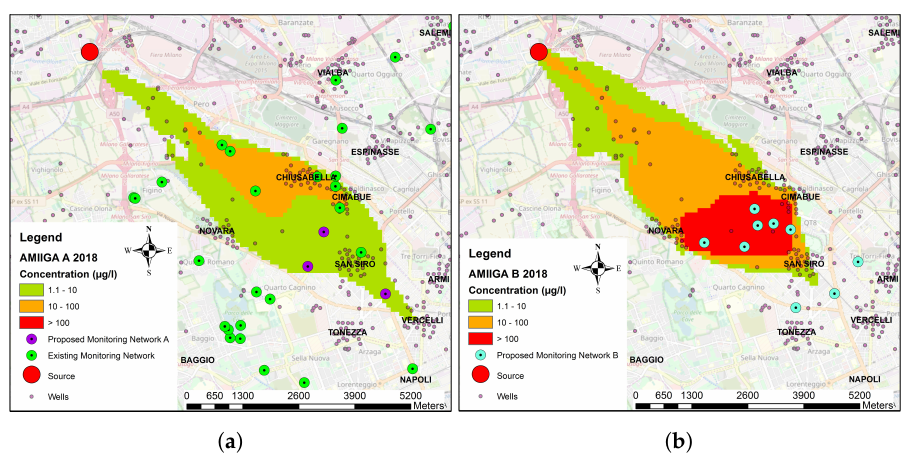
Figure 11. Proposed monitoring networks for ( a ) Aquifer A and ( b ) Aquifer